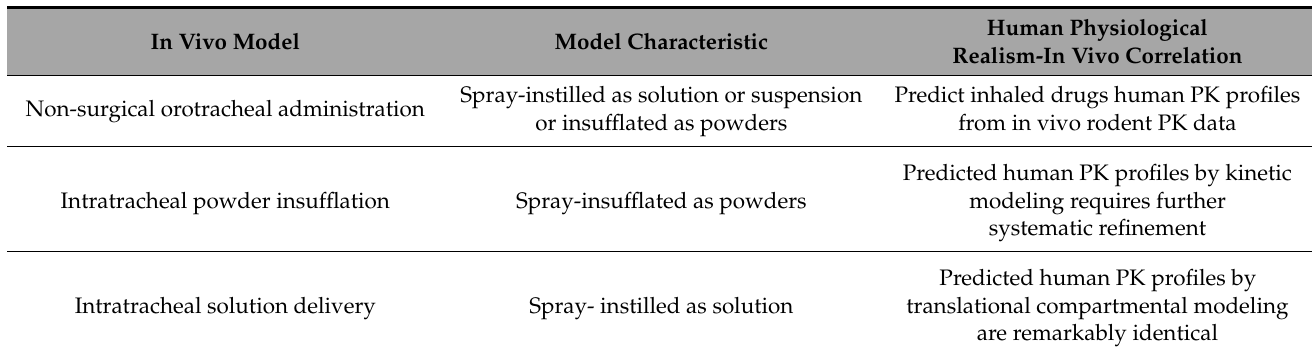
Table 5. Summary of in vivo whole animal-based models for testing inhaled aerosolized mist/dried lipid bilayer